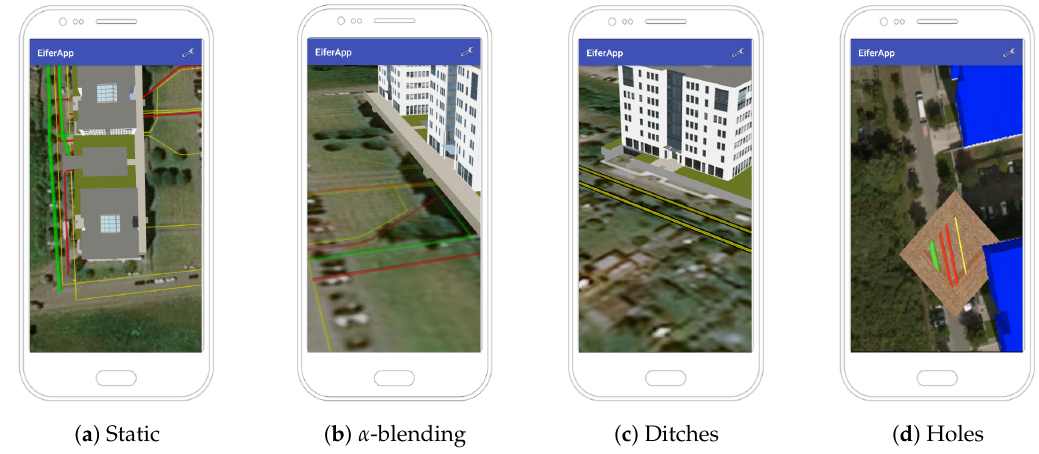
Figure 6. Strategies for visualization of underground